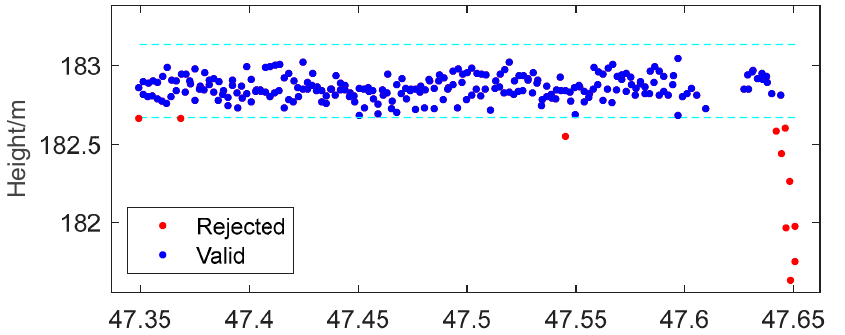
Figure 3. Sentinel-6 satellite outlier detection example over the 9099090 station. The result shows valid (blue) and rejected (red) water levels. The confidence limit is the cyan dotted line. Table 4. Parameters and quality control marks used in satellite measured water level.